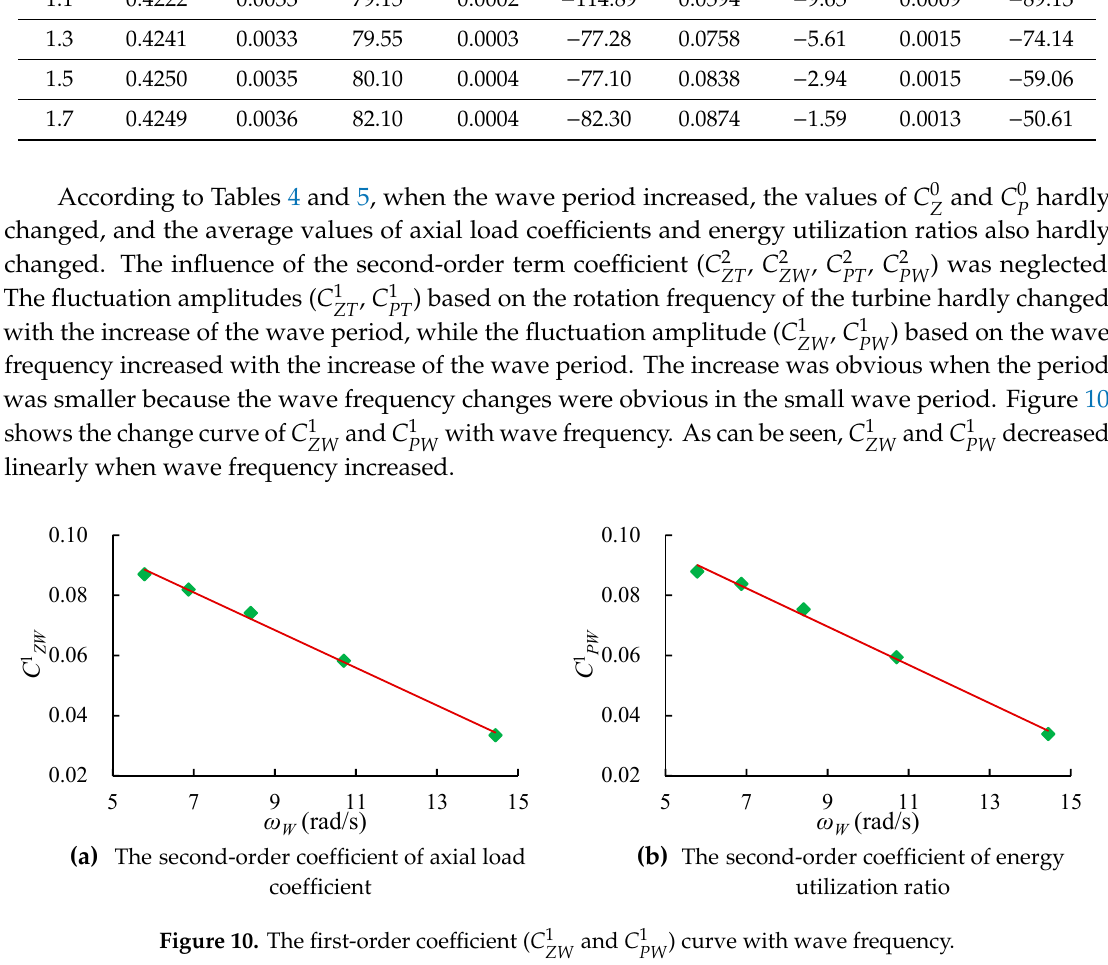
C and 1 C ) curve with wave frequency. Figure 10. The first-order coe ffi cient ( C 1 and C 1 ) curve with wave PW ZW ZW PW